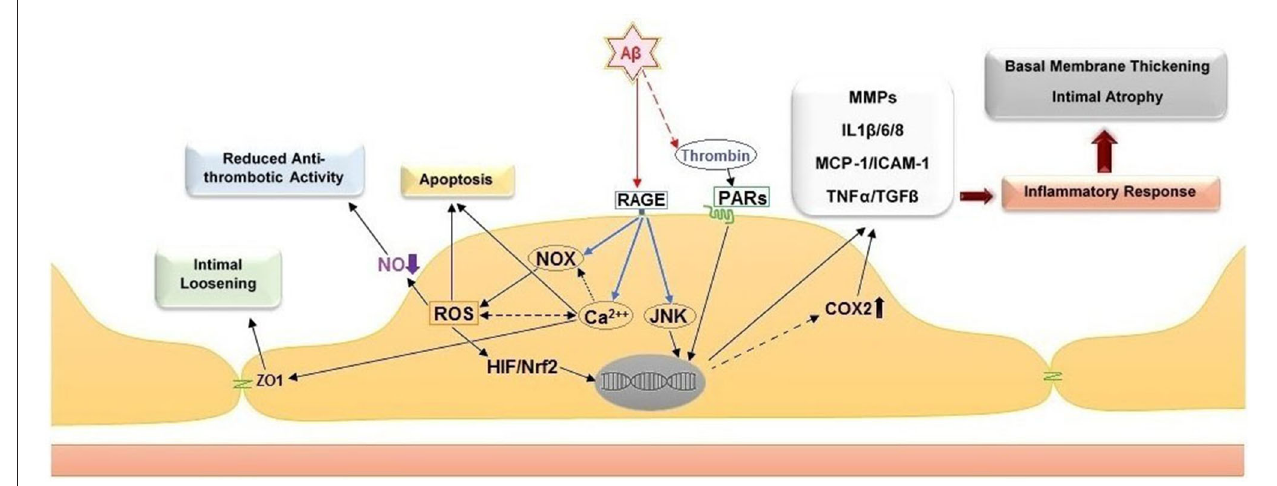
interleukins 1 β /6/8 (IL1 β /6/8), monocyte chemoattractant protein-1 (MCP-1), intercellular adhesion molecule 1 (ICAM-1), tumor necrosis factor α (TNF α ) and transforming growth factor beta (TGF- β ). Additional effect of ROS increase are the reduction of nitric oxide (NO) bioavailability, which leads to pro-thrombotic endothelial cell phenotype, and apoptosis. The intracellular calcium increase leads to intimal loosening via zona occludens protein 1 (ZO-1). The accumulation of thrombin in the amyloid plaques further facilitates endothelial inflammation via stimulation of the protease-activated receptors